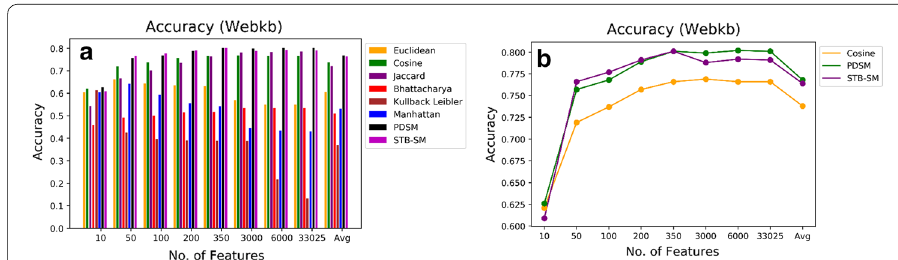
Fig. 4 a Accuracy over all Measures on all NF values– Average results (K over competitive measures on all NF values– Average results (K